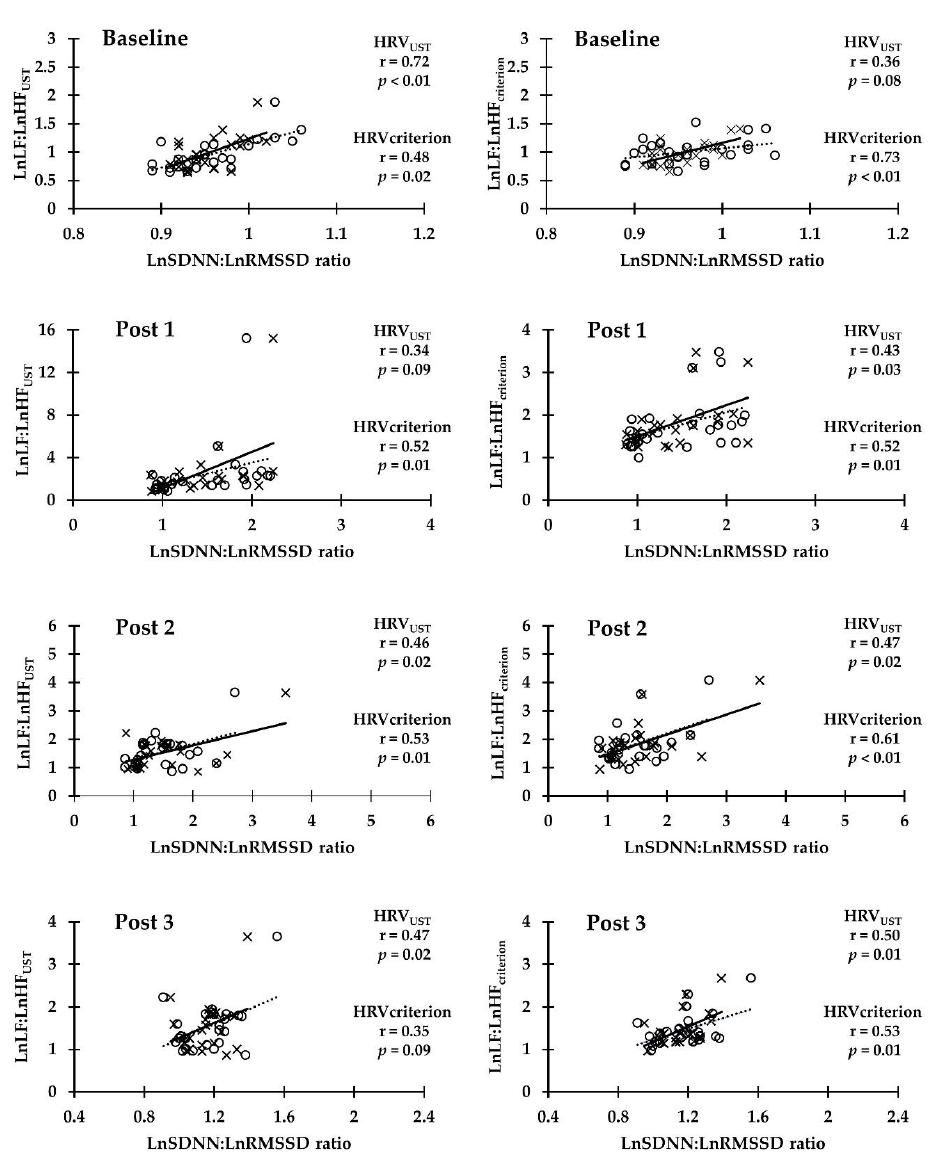
Figure 2. Pearson correlation coe ffi cient between LnSDNN:LnRMSSD ratio and LnLF:LnHF ratio (1 min and criterion) at baseline, post exercise 0–5 min (Post 1), post exercise 5–10 min (Post 2), and post exercise 25–30 min (Post 3) in repeated sprint ability test. Scatter plots between 1 min LnSDNN:LnRMSSD ratio and LnLF:LnHF ratio are presented as open circles (dotted line). Scatter plots between criterion of LnSDNN:LnRMSSD ratio and LnLF:LnHF ratio are presented as cross marks (solid